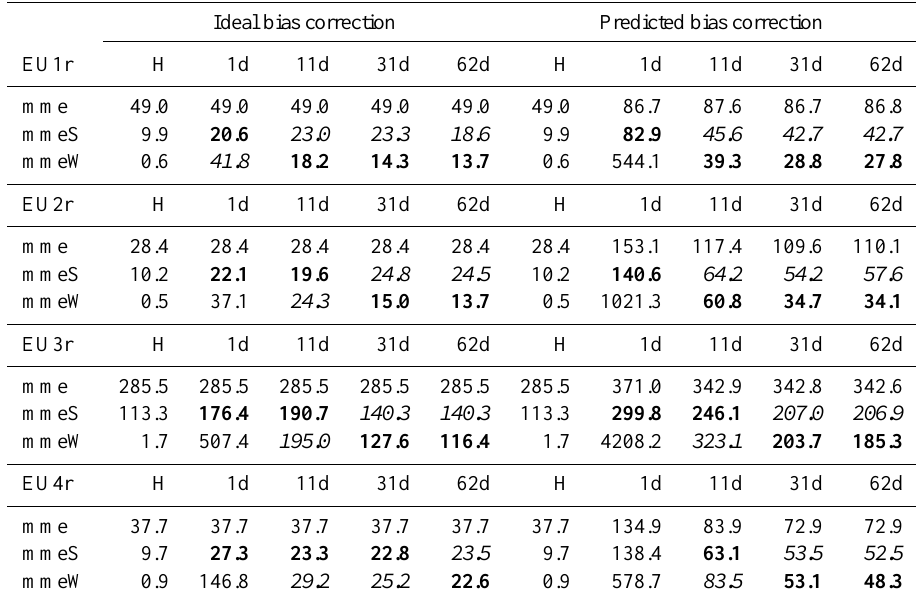
Table 3. The mean MSE of the 30 daily cases, in training mode ( H ) and testing mode as a function of the training period length (1 day, 11 days, 31 days, 62 days) and ideal/non-ideal bias correction. The comparison has been applied to four European sub-regions and three selected ensemble products (mme, mmeW, mmeS). The cases with MSE lower than mme are given in italics and the best member is displayed in